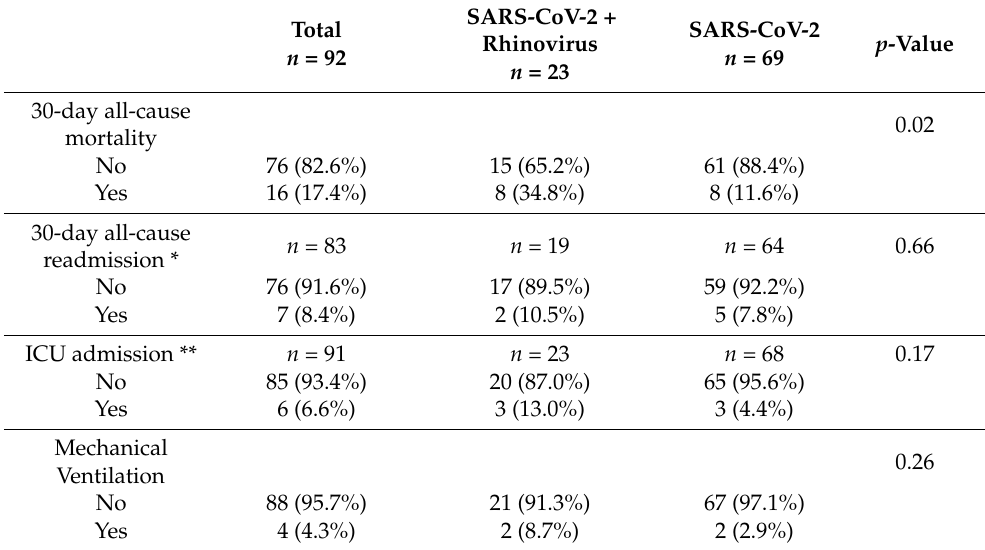
Table 3. Clinical outcomes between adults with SARS-CoV-2 + rhinovirus infection or SARS-CoV-2